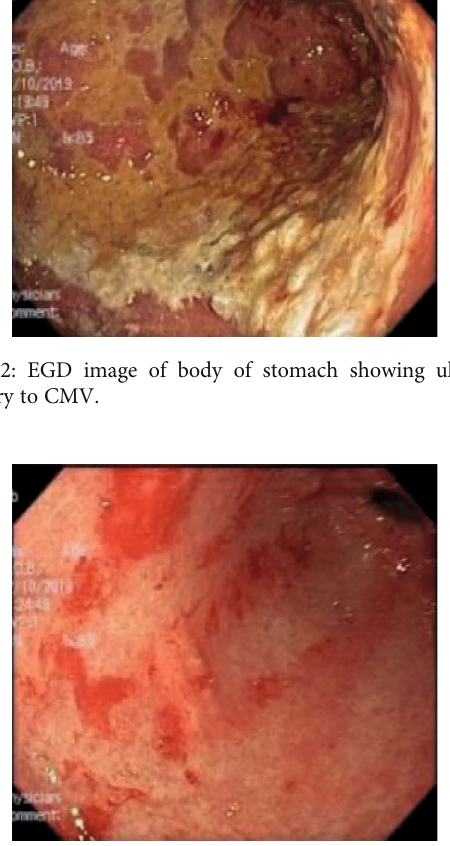
Figure 3: EGD image of antrum of stomach showing ulceration secondary to